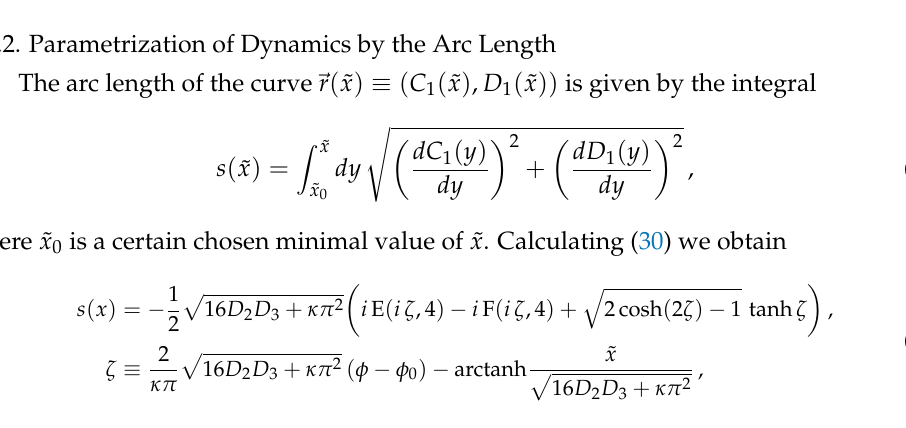
Figure 2. D 1 ( ˜ x , φ ) (left) and C 1 ( ˜ x , φ ) (right) as functions of ˜ x for fixed values of φ = 0.2 (red, dotted), φ = 0.4 (green, dashed) and φ = 0.7 (blue, solid); these are cross-sections of plots from Figure